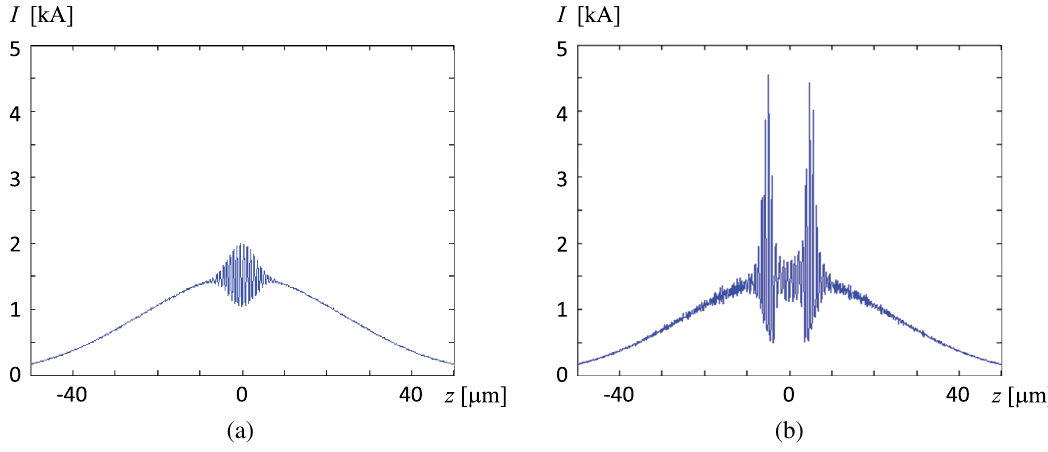
FIG. 8. Application A: current (a) before and (b) after the third chicane, for 30 fs (FWHM) laser modulation, calculated with 20 million